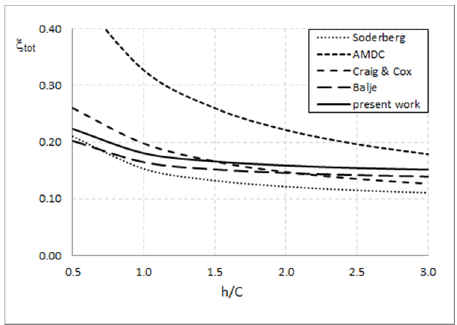
Figure 7. Loss coefficients obtained from the present work compared with traditional estimation methods for an impulse blade λ 1 = 150° and λ 2 = 30°.